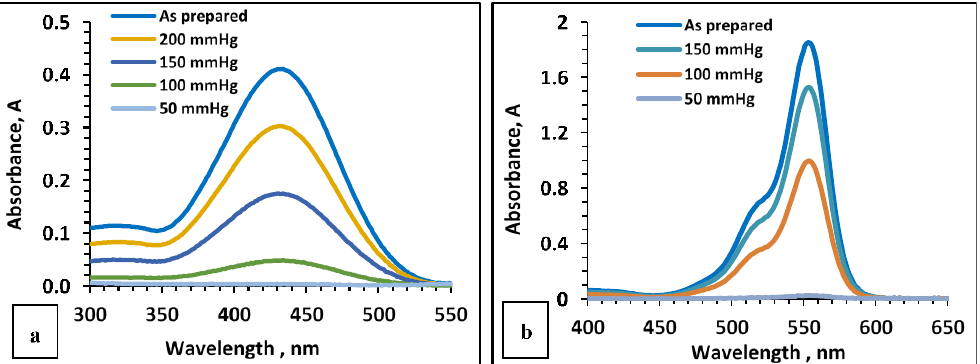
Figure 5. Spectrum removal after filtration of 5 mL solutions at 10 ppm concentration of ( a ) phenol red, ( b ) rhodamine B, using different vacuum pressures.